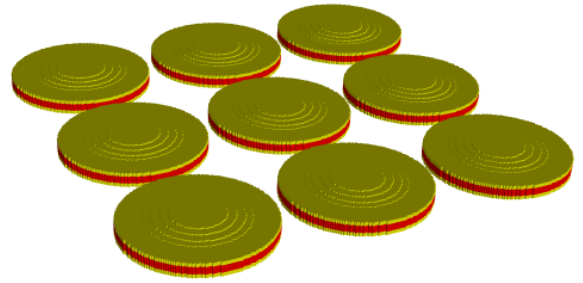
Figure 3. The cymbal array.